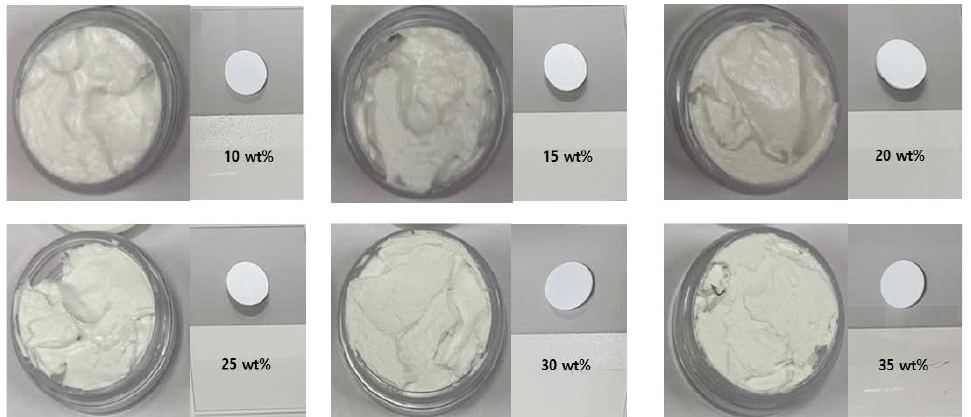
Figure 3. Barium sulfate protective cream according to wt% observed with the naked eye.